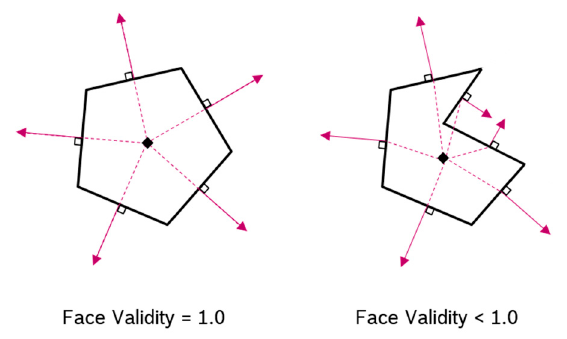
Figure 7. Face validity STAR-CCM+, criteria for mesh quality.